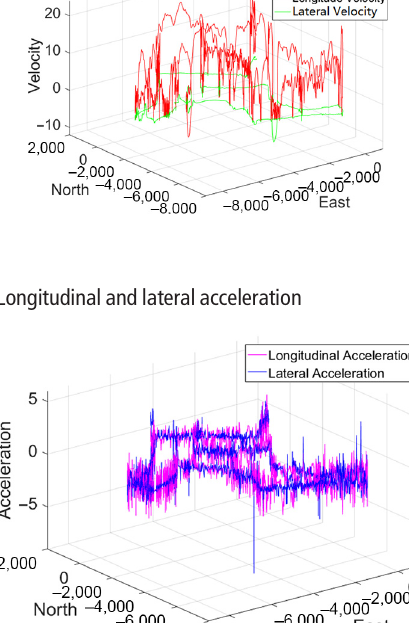
Figure 4, the green line indicates lateral velocity, and the red line indicates longitudinal velocity. It can be seen that the lateral velocity changes are relatively stable, and the lateral velocity has a small variance value, indicating that the lateral longitudinal velocity. The range of variation is large. In Figure 5, the blue line represents lateral acceleration, and the purple line represents longitudinal acceleration. There are